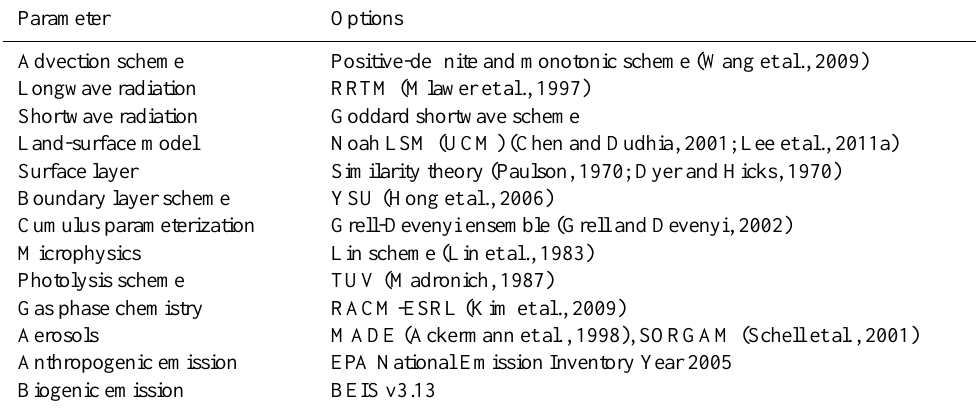
Table 1. WRF-Chem model configuration used in this